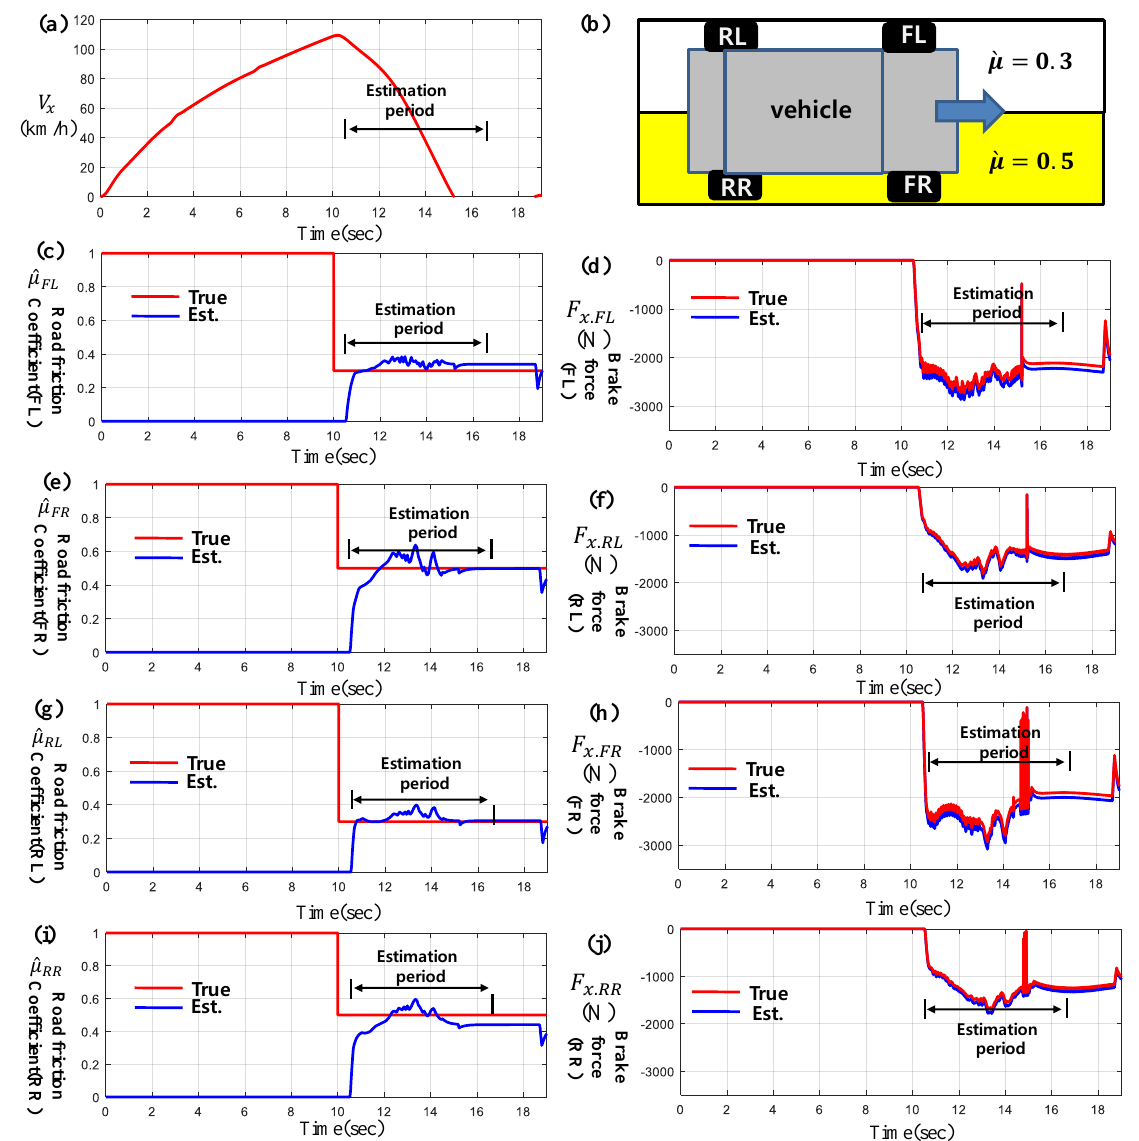
Figure 16. Estimation results of road friction coefficients and brake forces for split-friction road. ( a ) Longitudinal vehicle speed, ( b ) split-friction road condition ( 𝜇 = 0.3 for left and 𝜇 = 0.5 for right), ( c ) friction estimation of FL wheel, ( d ) brake force of FL wheel, ( e ) friction estimation of FR wheel, ( f ) brake force of FR wheel, ( g ) friction estimation of RL wheel, ( h ) brake force of RL wheel, ( i ) friction estimation of RR wheel, and ( j ) brake force of RR wheel. Table 3. Correlation coefficient for data comparison of brake forces for Figures 15 and 16. Front Axle Rear Axle Left: 93.03% match Left: 93.08% match First brake (Figure 15) Right: 96.21% match Right: 92.12% match Left: 90.85% match Left: 91.05% match Second brake (Figure 16) Right: 93.60% match Right: 95.09% match